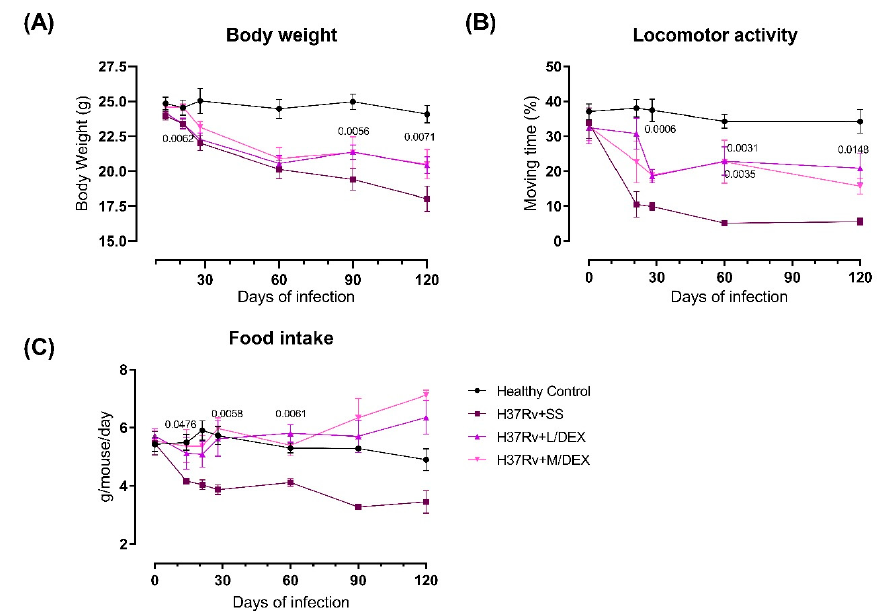
Figure 2. Effect of IN L/DEX (0.05 mg/kg BW) and M/DEX (0.25 mg/kg BW) in TB mice’s sickness behavior. ( A ) Bodyweight loss of infected animals that received L/DEX, M/DEX, control mice that only received the vehicle saline solution